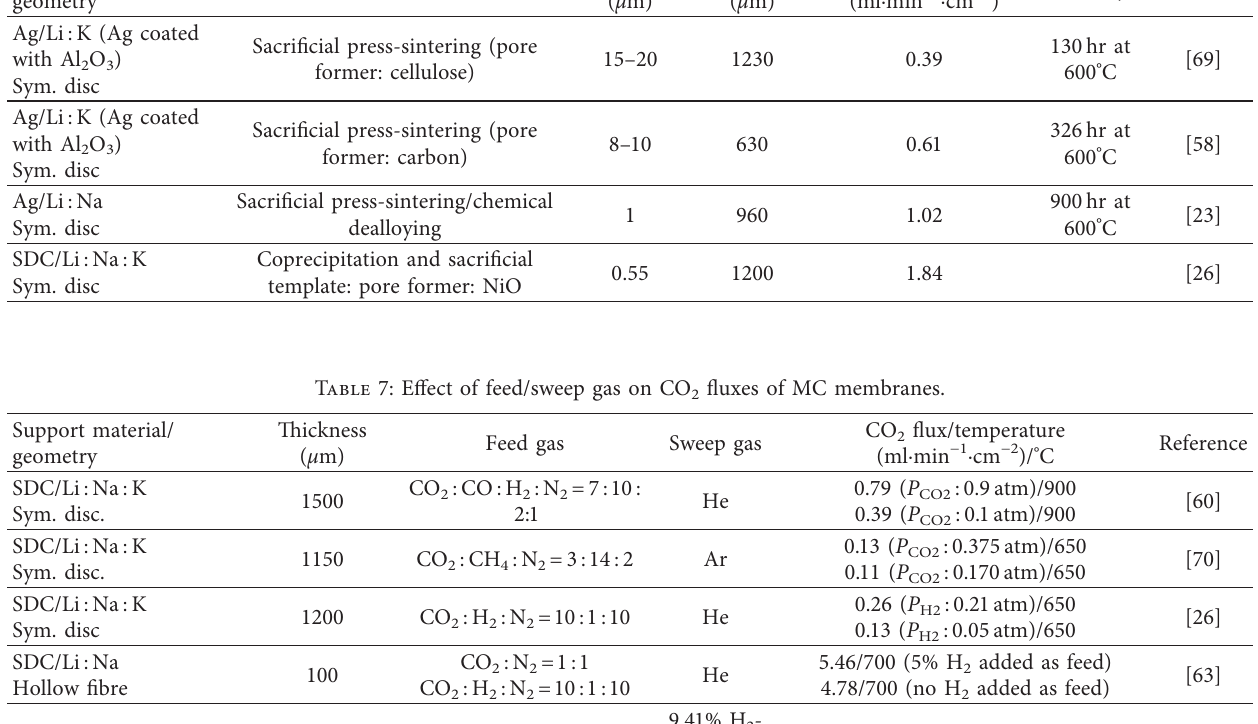
Table 6: Comparison of CO 2 fluxes for MC membranes with support microstructures of different pore sizes. Support material/ geometry